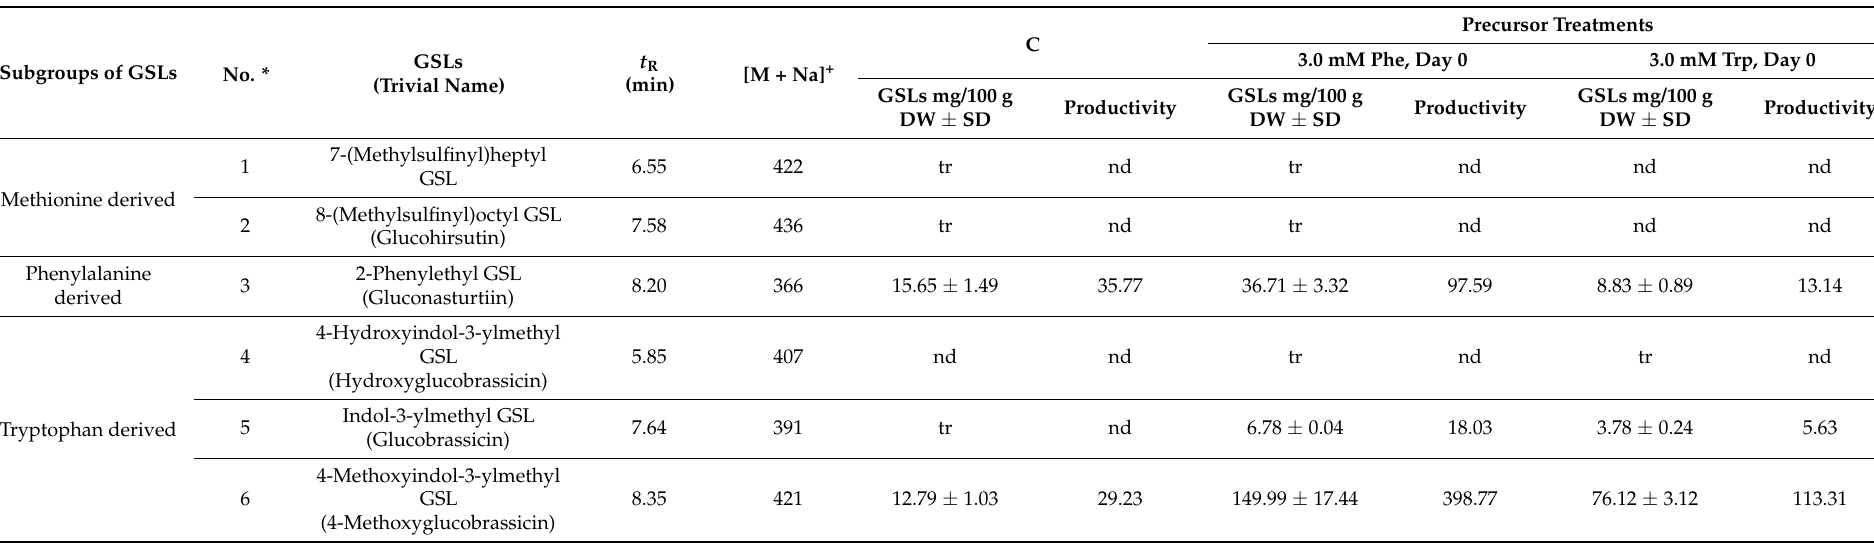
Table 5. The UHPLC-DAD-MS/MS GSLs profile and productivity of bioreactor-grown N. officinale microshoot cultures after precursor feeding.